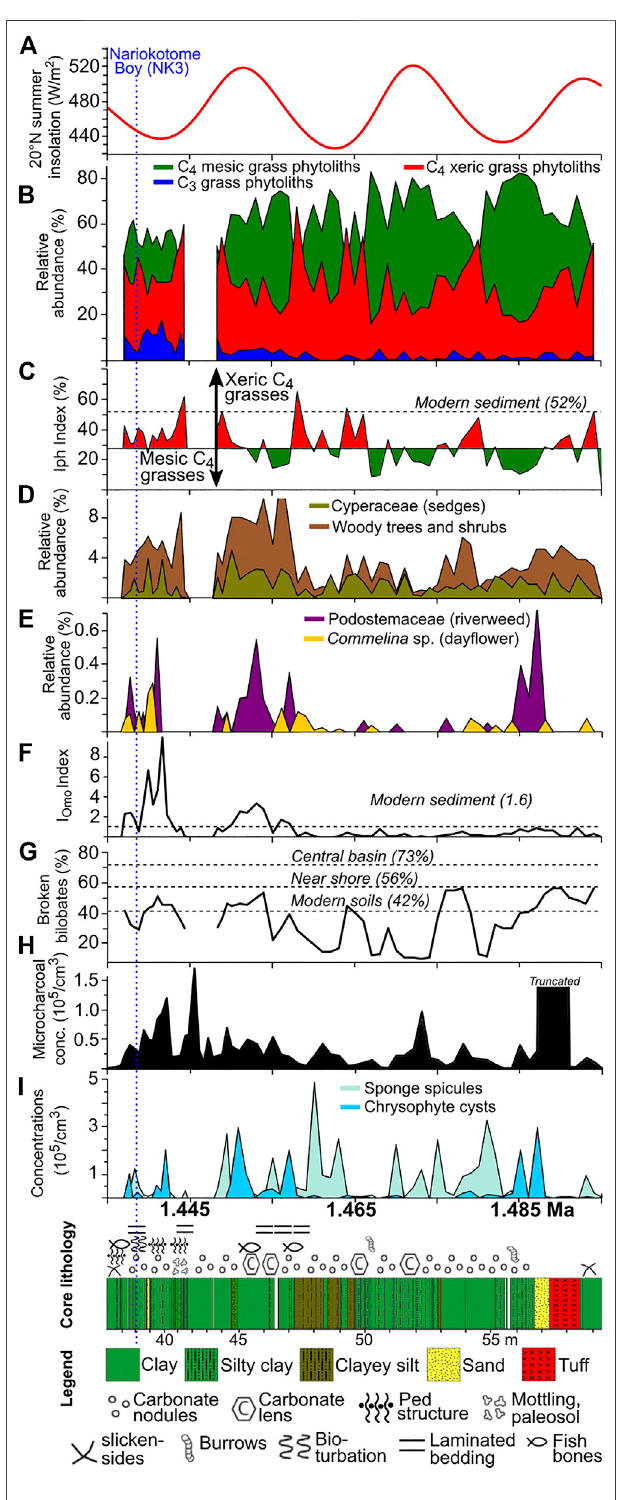
FIGURE 8 | Microfossil summary plots for Zone 6 (1.50 – 1.435 Ma). (A) 20 ° N summer insolation (Laskar et al., 2004). (B) Relative abundance of C 3 and C 4 grass functional types based on short-cell phytoliths. (C) Iph aridity index with xeric short-grass/mesic tall-grass transition set at 27.8% (Novello et al., 2017). (D) Relative abundance of tree/shrub and Cyperaceae